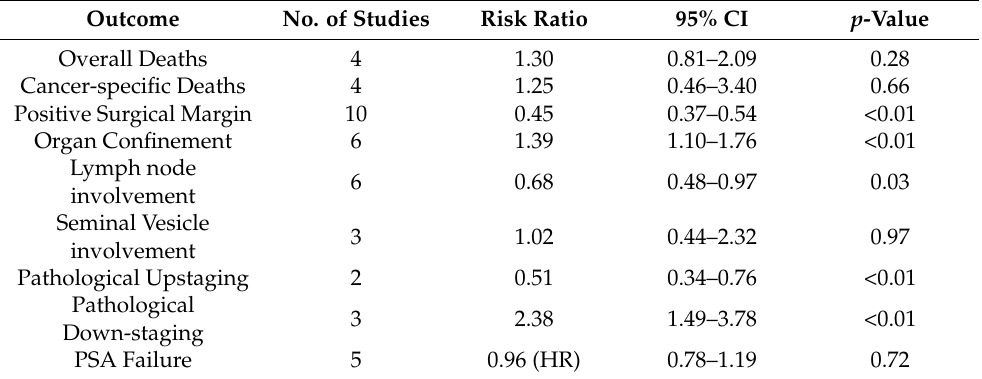
Table 1. Summary of meta-analyses comparing 3 months of NHT and delayed RP versus immediate